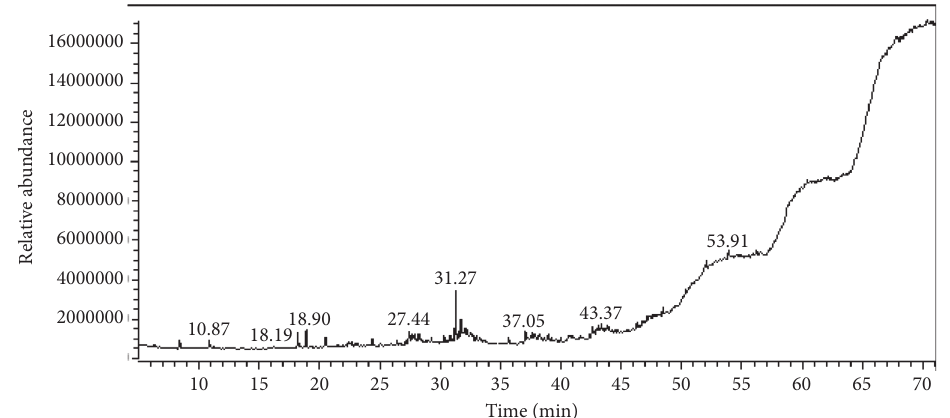
Figure 1: Total ion GC-MS chromatogram of the ethanol extract of S. persica